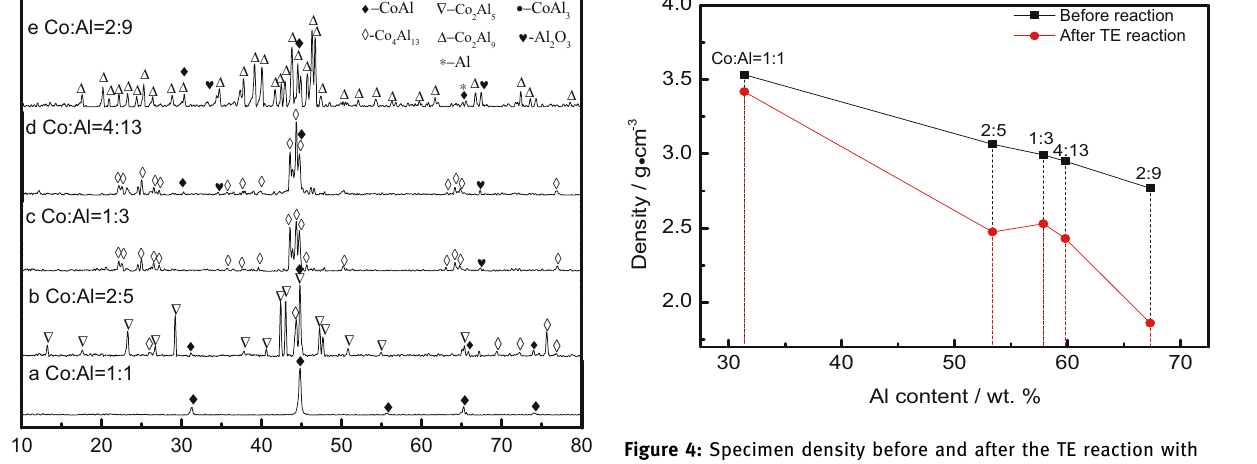
Figure 4: Specimen density before and after the TE reaction with different Co/Al molar ratios.